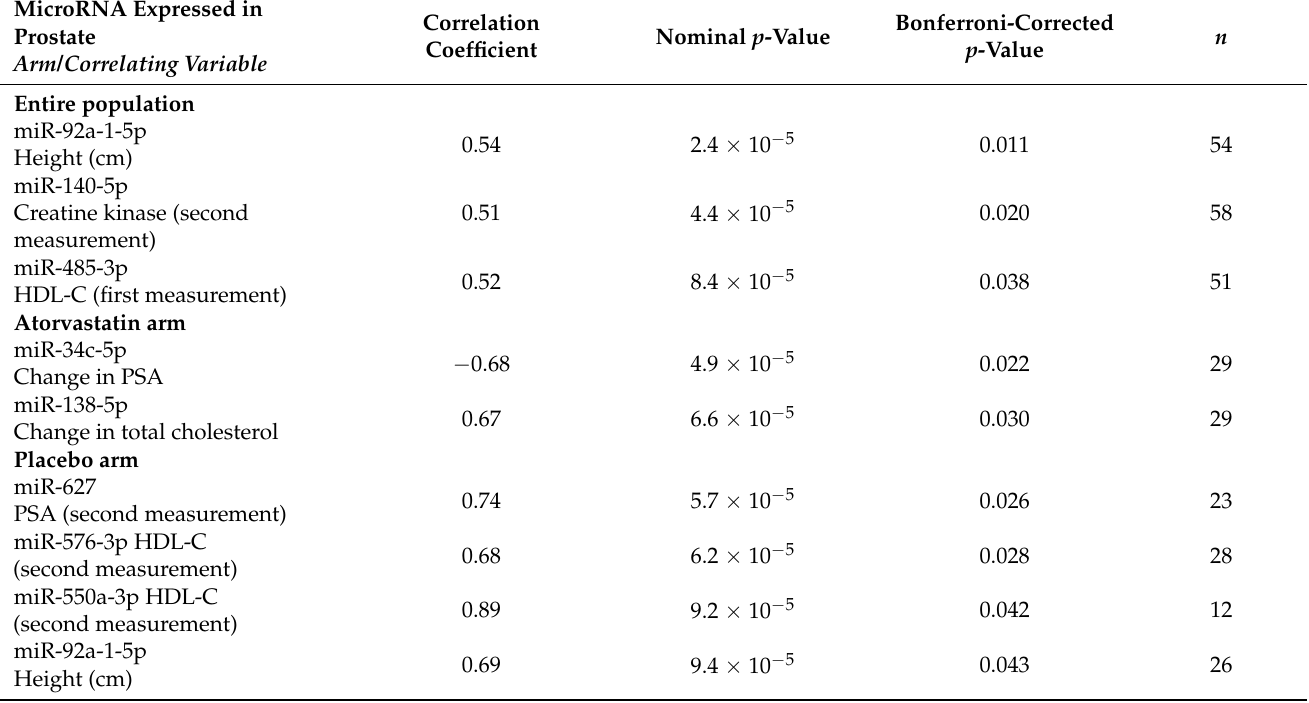
Table 2. Significant correlations found in the entire study population and in subgroup analyses. Correlation coefficients were calculated between the miRNAs and the characteristic presented under it in italics, using the Spearman’s rank-order correlation. n is the number of subjects included in each